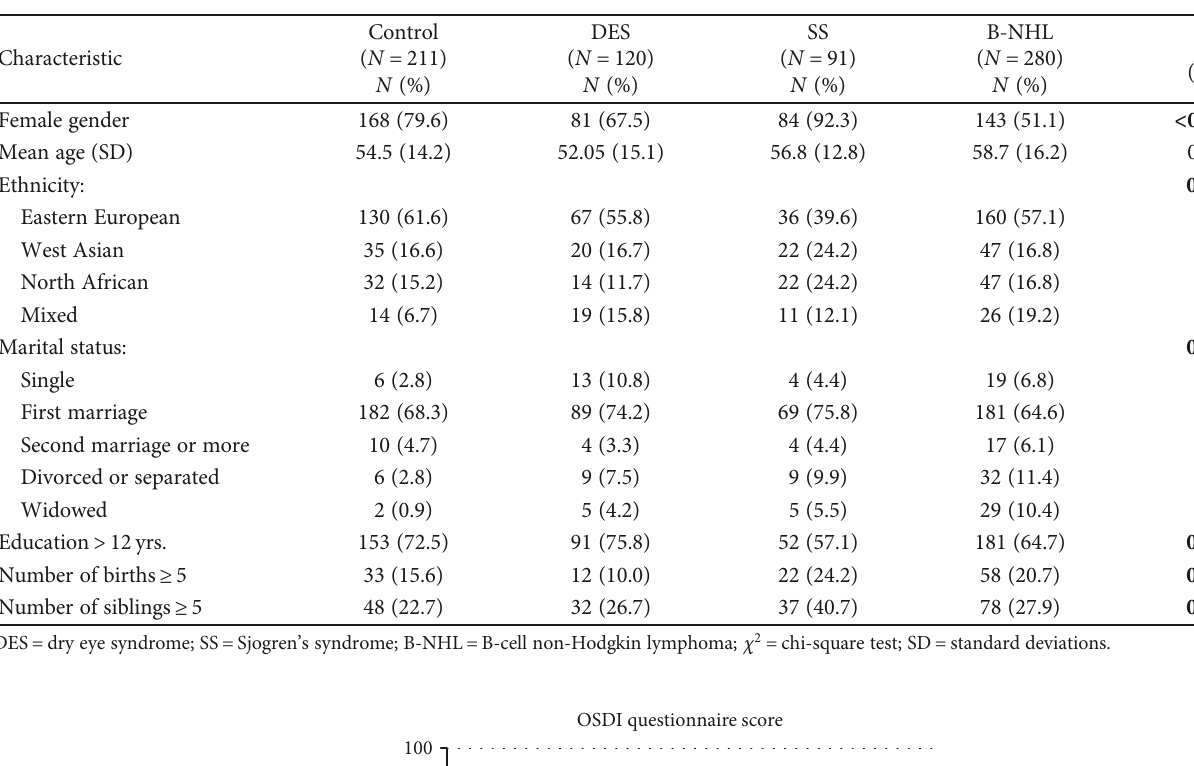
Table 1: Demographic characteristics of study population.